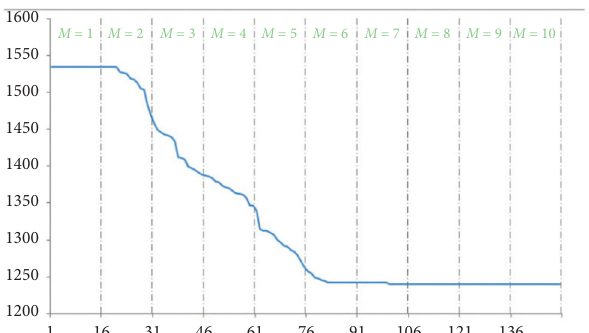
Figure 2: Convergence of the Simulated Annealing search for � 10 and L � 15. M max max